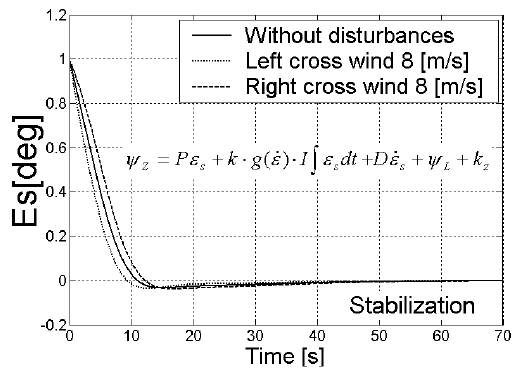
Fig 4b. Simulation results for stabilization with the use of control law